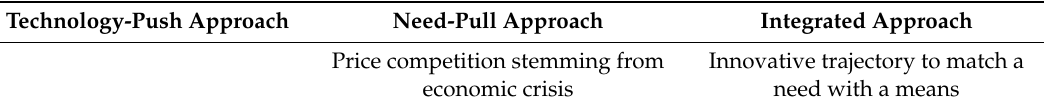
Table 4. Summary of the adoption drivers for Bruil.